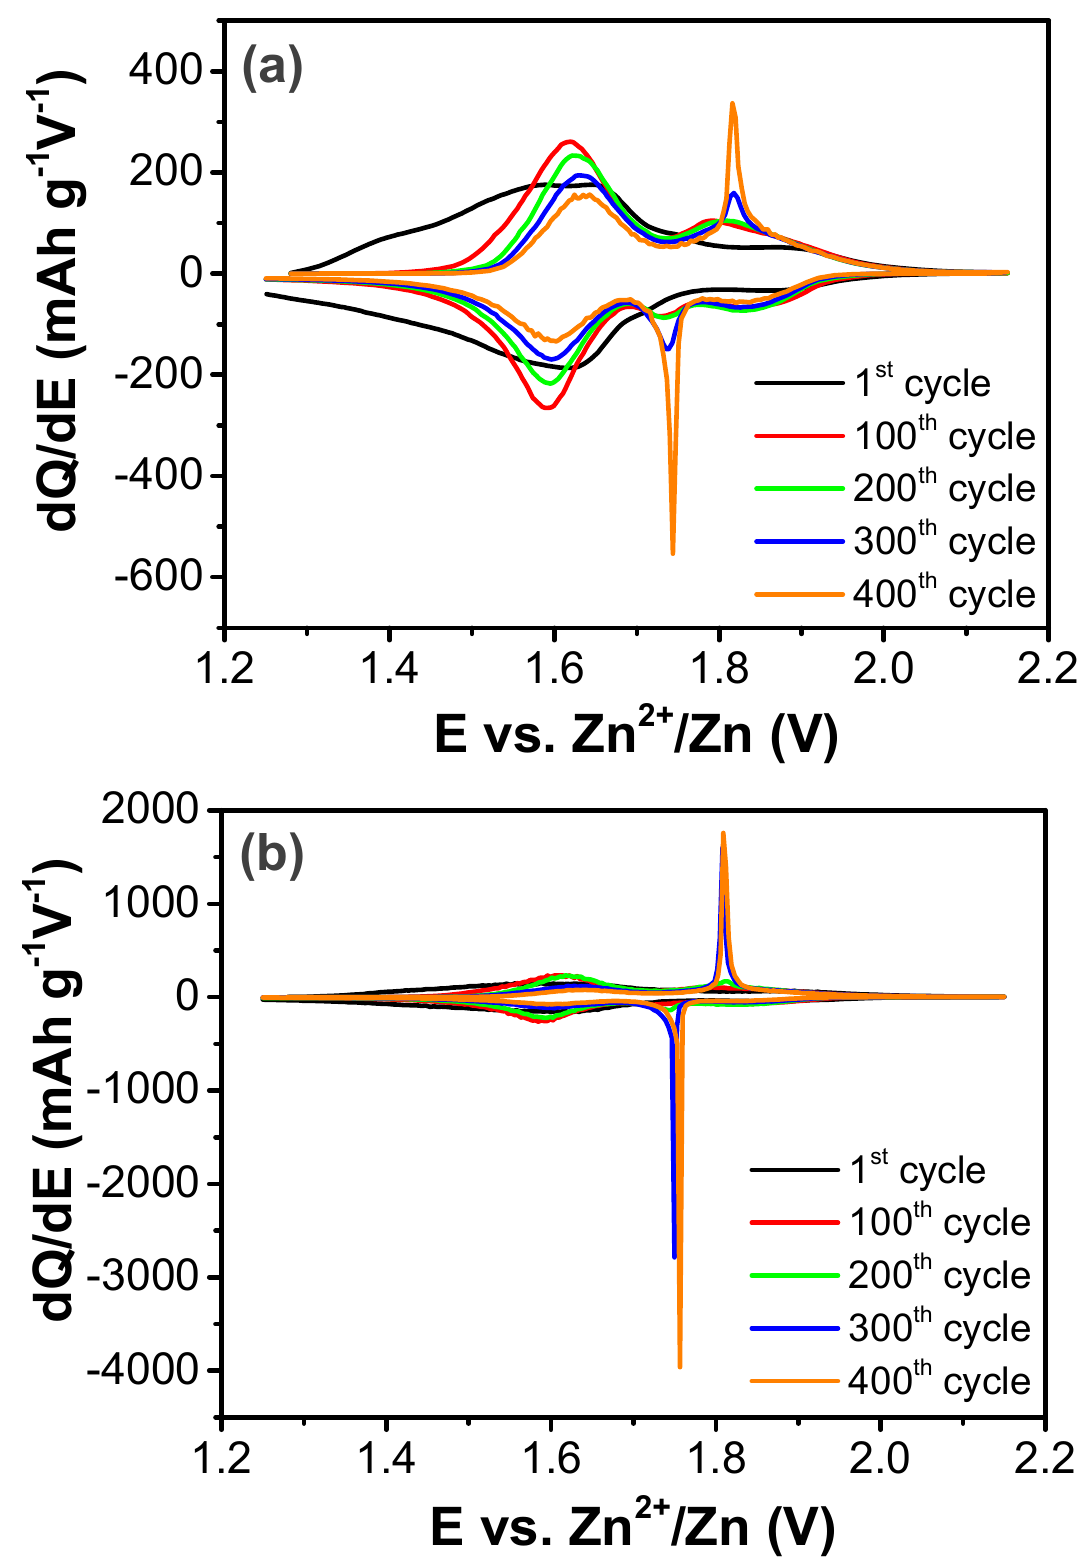
Figure 10. Differential charge plots for ( a ) untreated and ( b ) 100 °C-annealed CuHCF electrodes. There has been speculation that such phase transitions may affect the aging of CuHCF. In our previous work [6], we suggested that such phase transitions and changes in the potential profile may also be related to the formation of a different insertion site, with Zn 2+ occupying vacancies in the CuHCF’s host structure, followed by the nucleation of ZnHCF after long-term cycling.